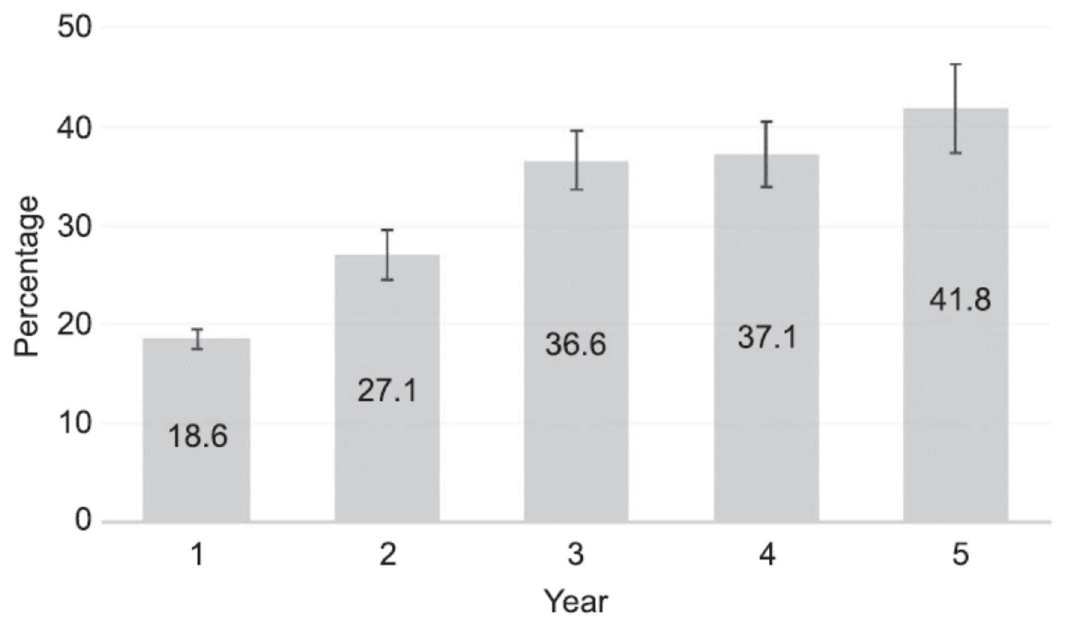
Figure 4. Rates of amenorrhea (defined as no bleeding or spotting during the preceding 90 days) over time in women bearing the LNG ‐ IUS. From: Teal et al. (2019) [105] (reproduced with permis ‐ time in women bearing the LNG-IUS. From: Teal et al. (2019) [105] (reproduced with sion).